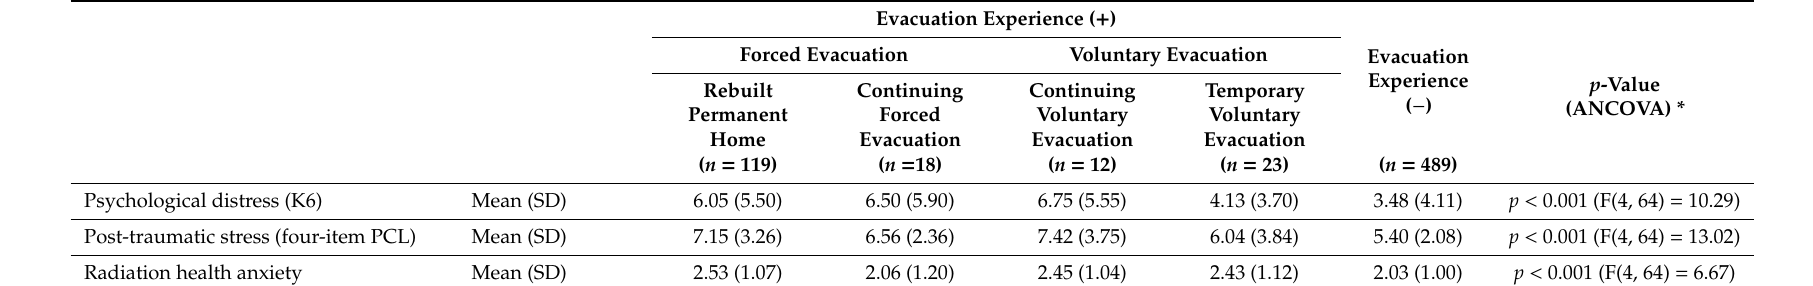
Table 3. Psychological distress, post-traumatic stress, and radiation health anxiety by